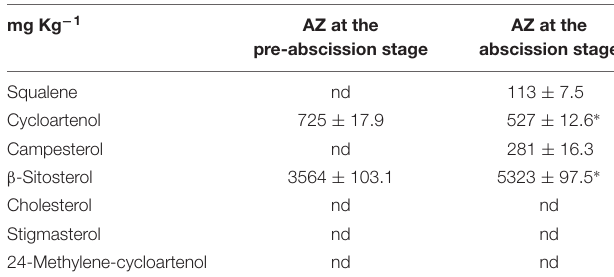
TABLE 1 | Changes in the total sterol content (mg Kg − 1 ) in olive AZ during mature-fruit abscission.